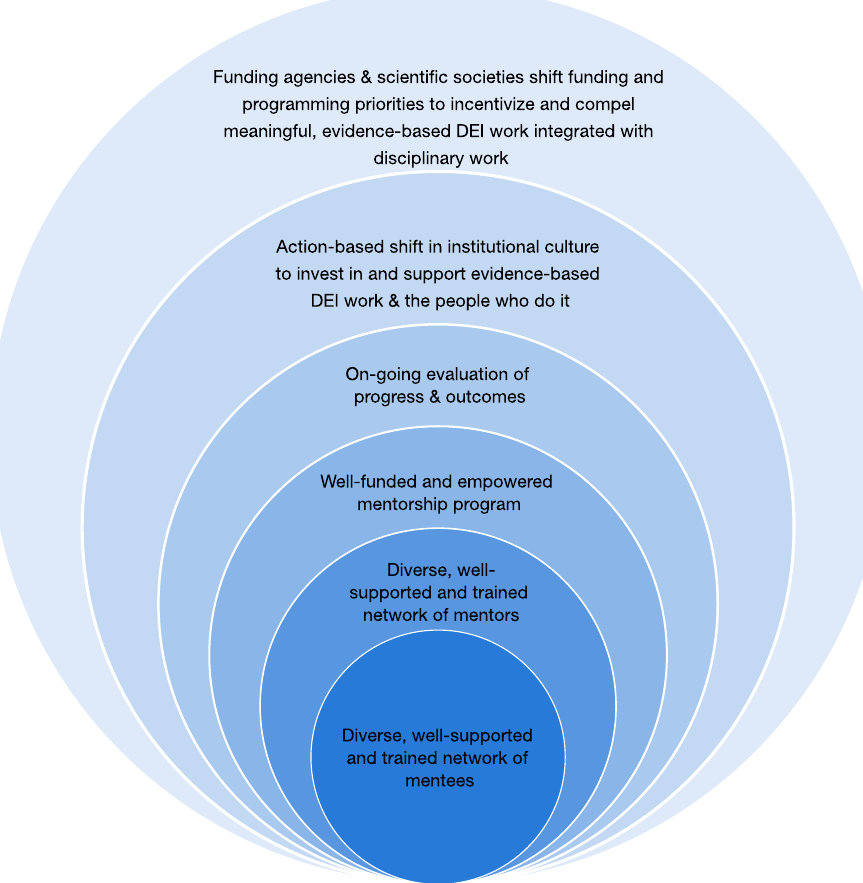
Fig. 2 Framework to build diverse multi-mentors networks. Establishing effective programs that promote diverse multi-mentor networks -- in which mentees and mentors are supported and trained to (1) build healthy relationships, (2) develop professionally, and (3) achieve success – is a layered process that depends on many embedded factors: a DEI assessment implemented by institutions, funding agencies, scienti fi c societies, and the community; b policy and work culture changes to promote evidence-based DEI work; c continuous support and evaluation of program implementation, progress, and outcomes; and d reassessment, adaptation, and reevaluation of programs to empower mentorship networks. As a dynamic system, all components feed from and are informed by the